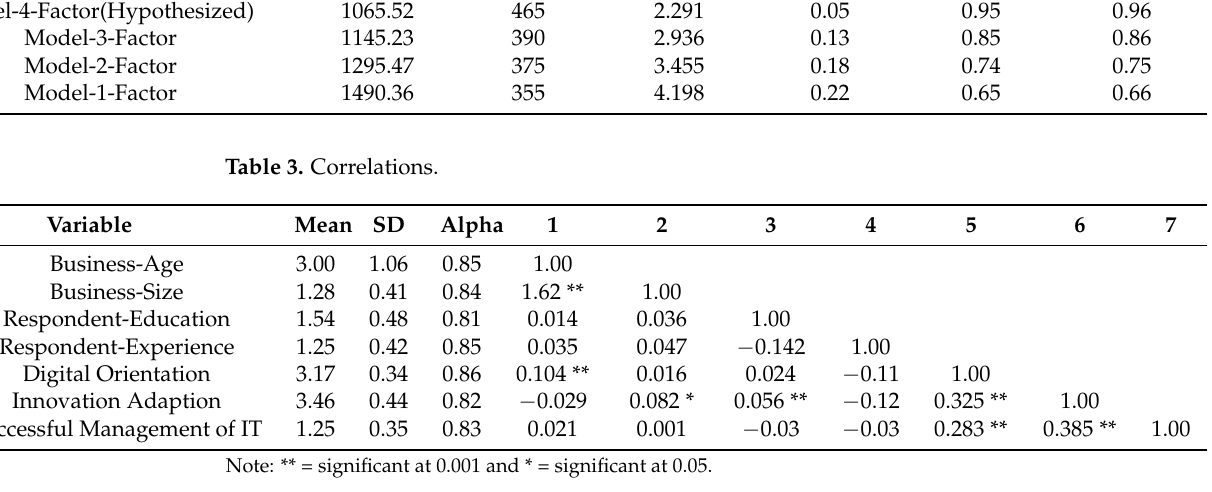
Table 4 show the results of our hypotheses: H1 proposed that digital orientation